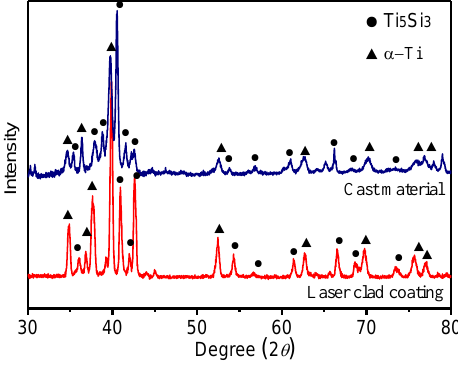
Figure 4. XRD patterns of the Ti–20%Si alloys.